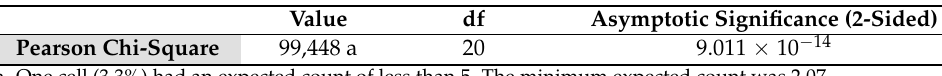
Table 19. Chi-square